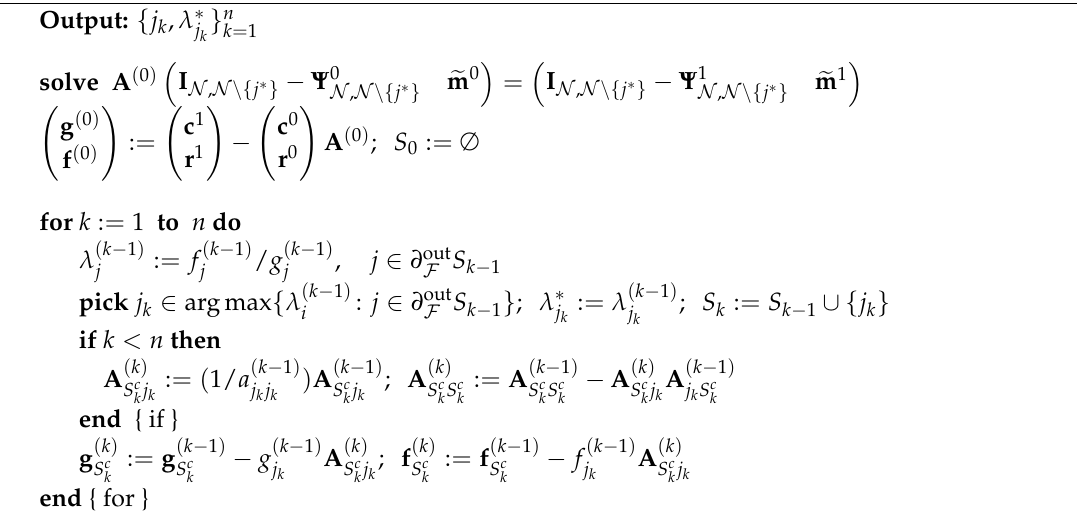
Algorithm 5: The fast-pivoting adaptive-greedy index algorithm FP F